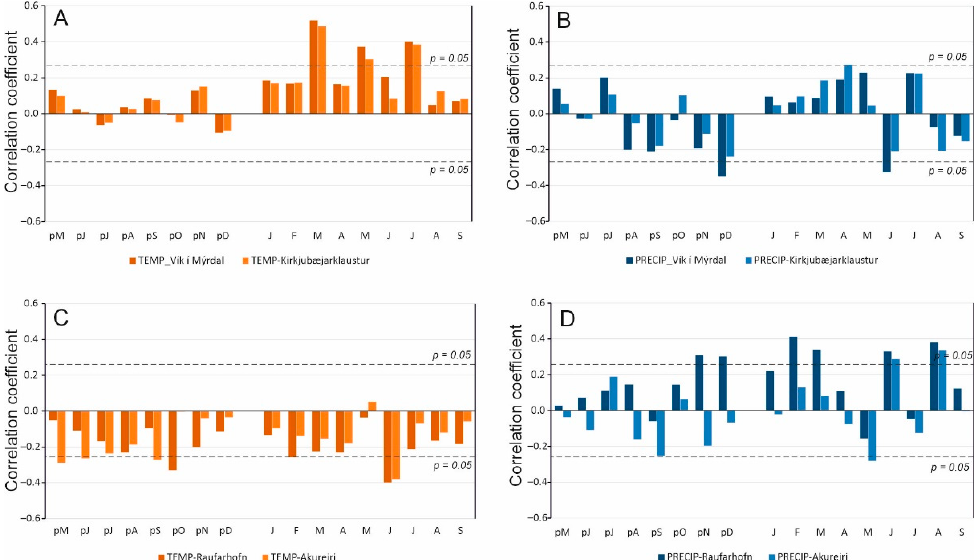
Figure 5. Correlation coefficients of growth ring data at two contrasting sites, Mýrdal ( A , B ) and Afrétt ( C , D ), to mean temperature and monthly precipitation totals from different meteorological stations.